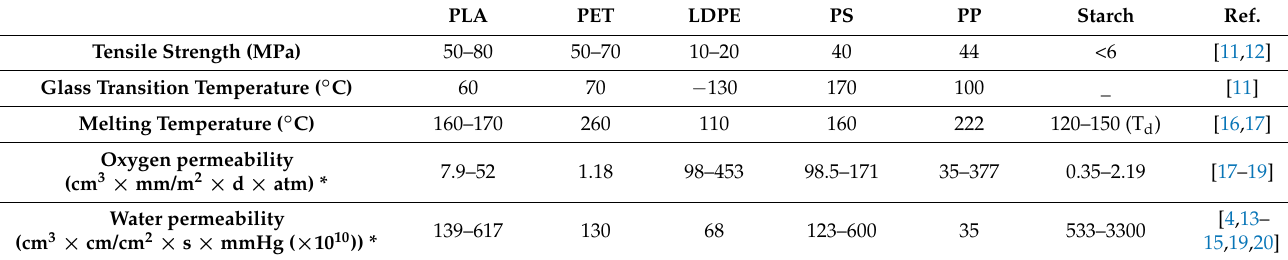
Table 1. Summary of physico ‐ mechanical properties of packaging polymers.